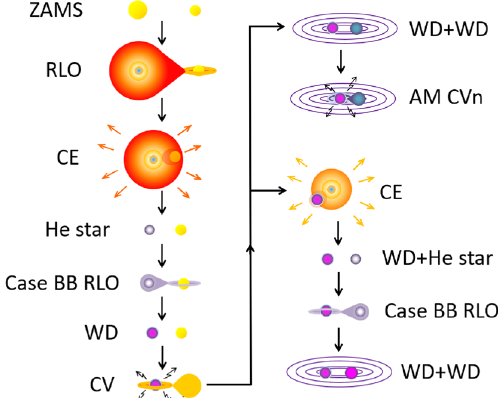
Fig. 6 Illustration of the formation of an AM CVn system and a detached WD ? WD binary. LISA sources are indicated